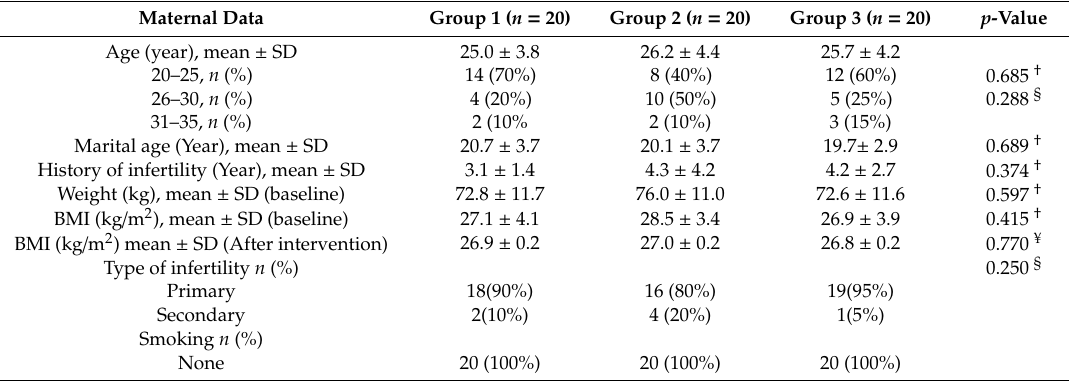
Table 3. General characteristics of the women with PCOS at baseline and after